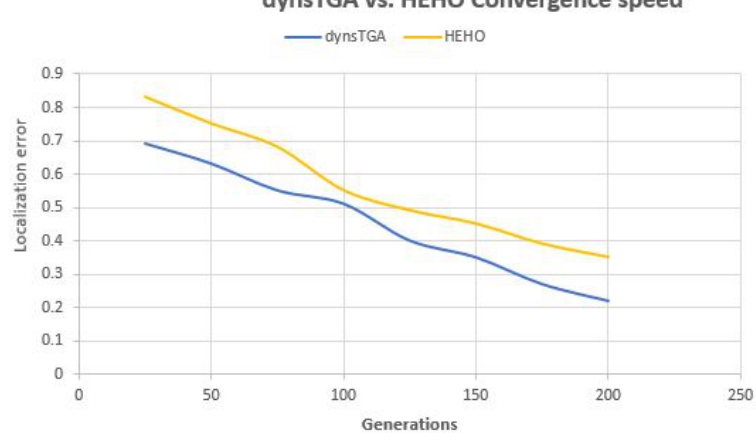
Figure 7. Convergence speed—dynsTGA vs. HEHO (100 targets and 25 anchors).